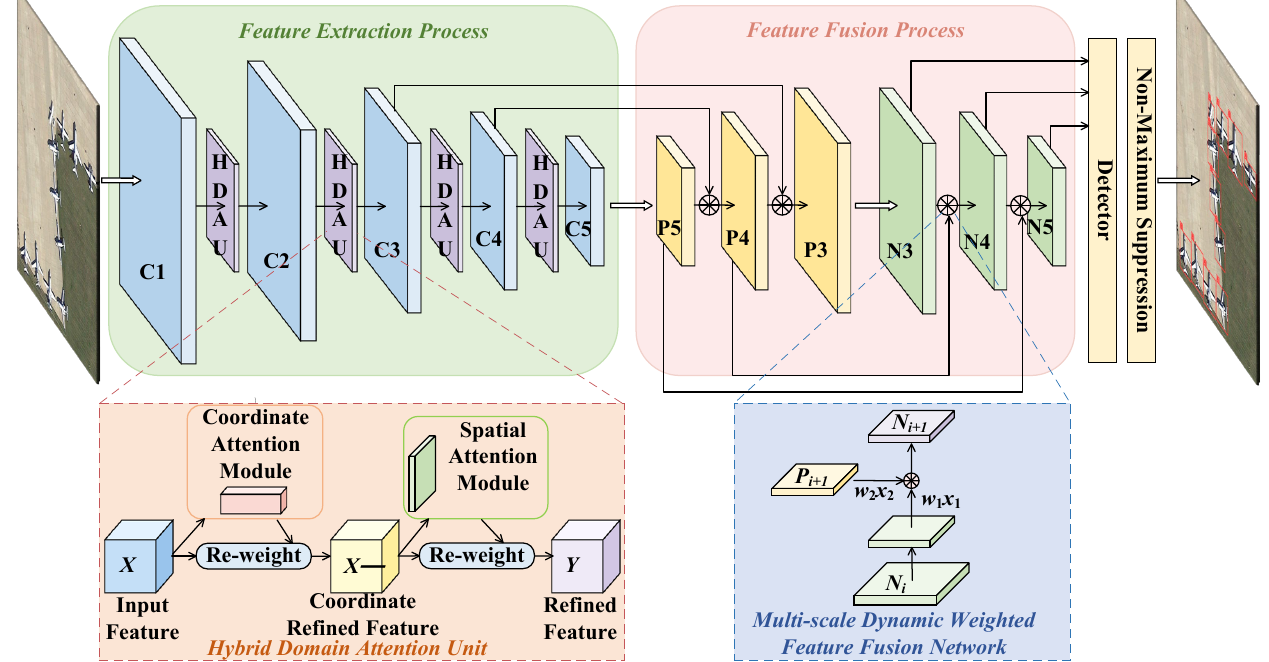
Figure 2. Architecture of the proposed HDAU-YOLO.